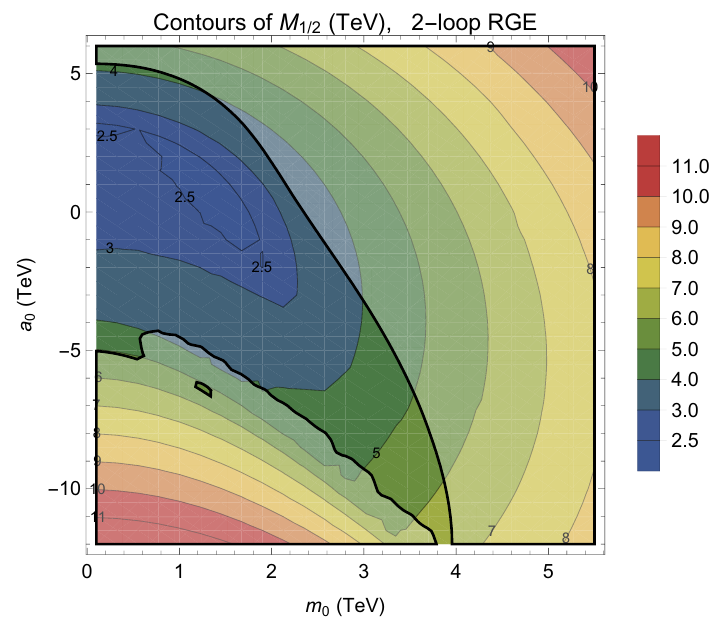
for a (cid:31) 2 best-(cid:12)t point 1 = 2